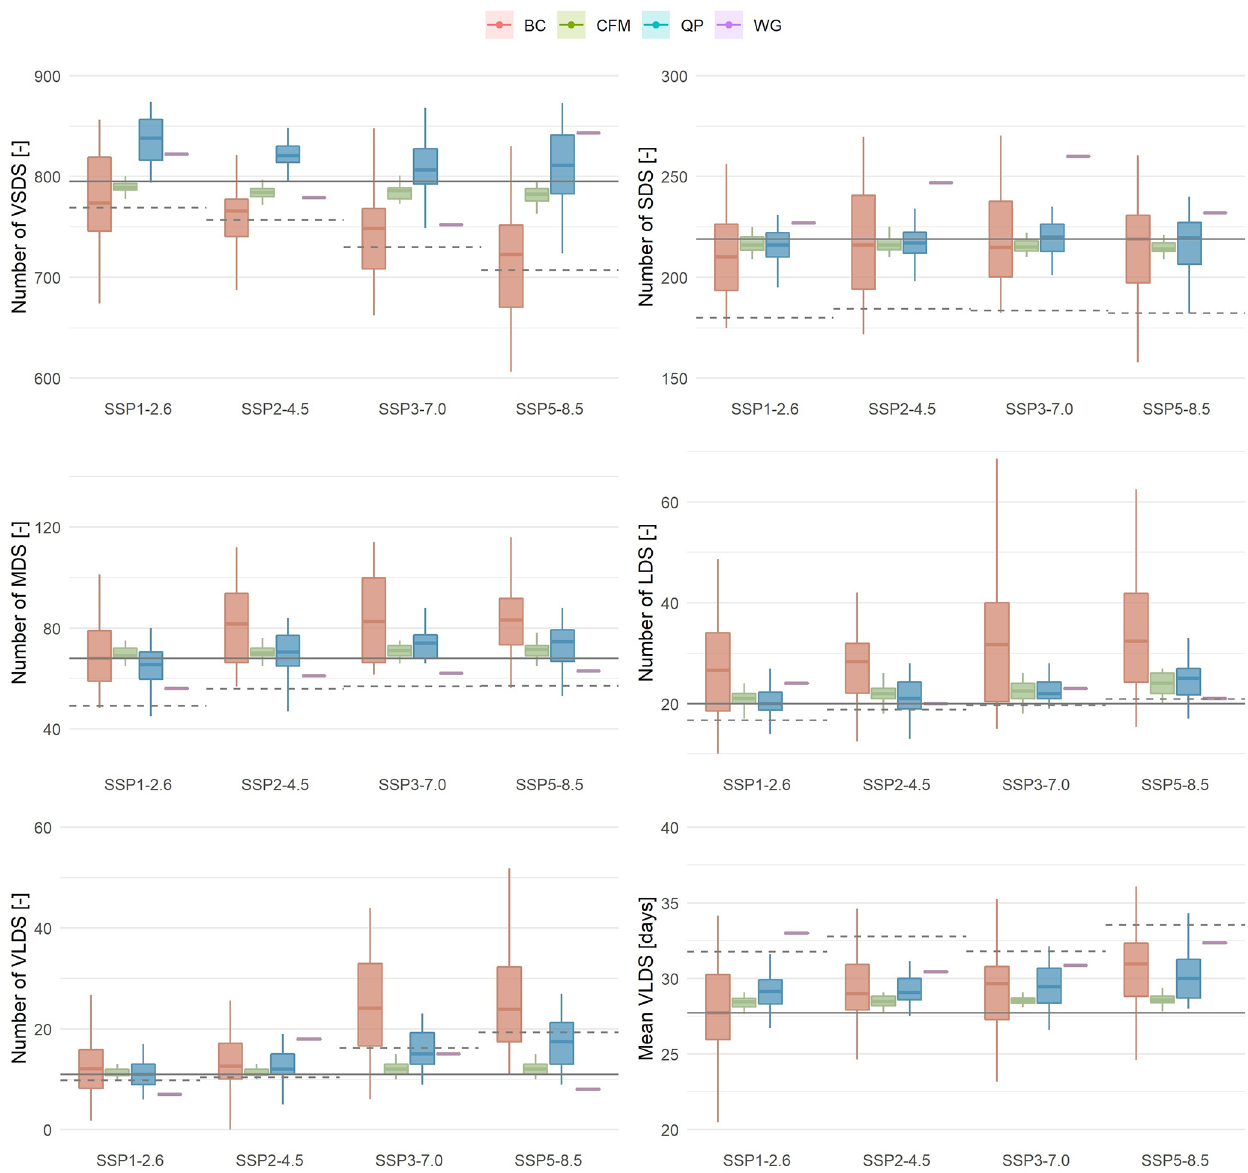
Figure 6. Box plot representation of results for number of dry spells and dry spell length under different future scenarios. WG downscales the ensemble as a whole, resulting in only one data point. CMIP6 GCM projections (not downscaled; dashed line) and Uccle observations (solid line) are given as a reference. VSDS, SDS, MDS, LDS and VLDS denote the very short, short, medium, long and very long dry spells, respectively. The top and bottom of the box show the 75th and 25th percentiles, respectively. The top and bottom of the whiskers show the 5th and 95th percentiles, respectively. The horizontal black line in the middle of the box represents the